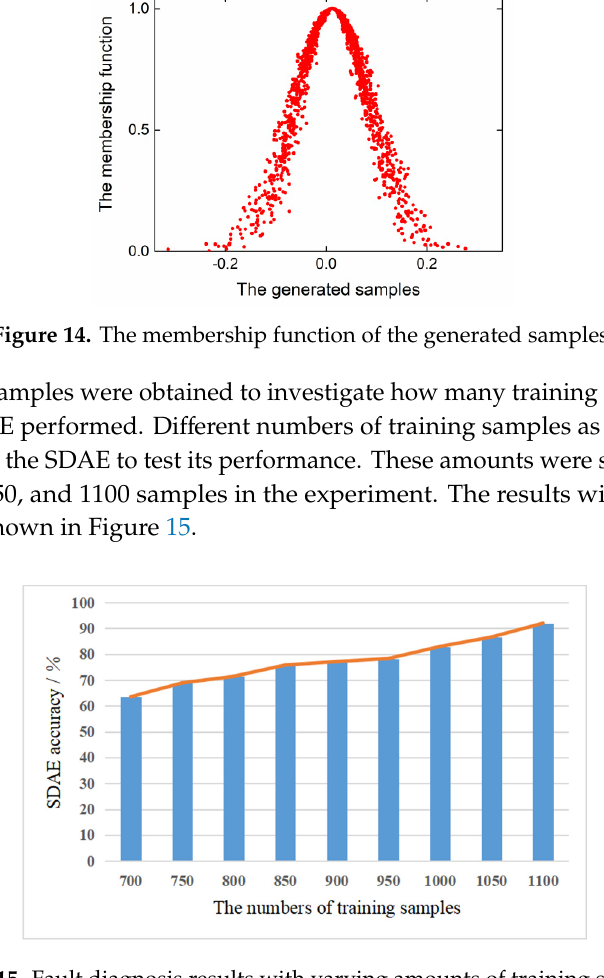
Figure 15. Fault diagnosis results with varying amounts of training samples.